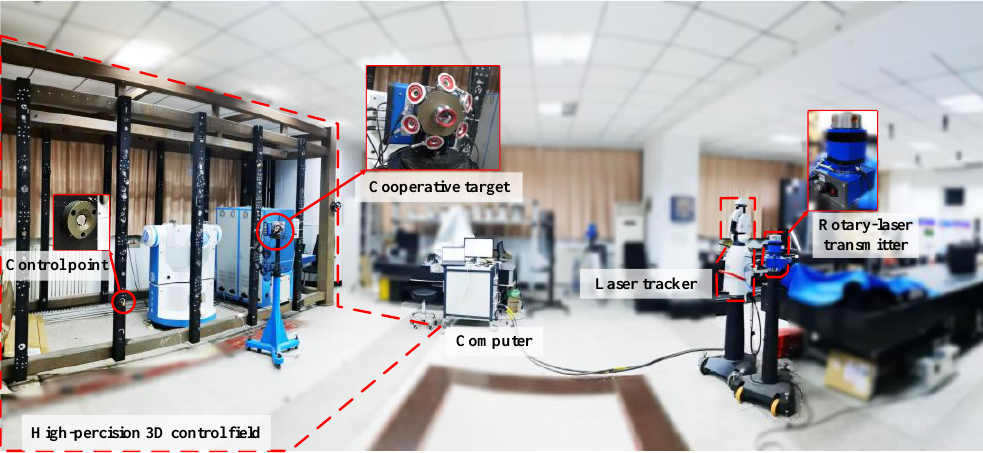
Figure 7. The layout of the devices, cooperative target, and the high-precision control field. Table 1. Coordinates of receivers and retroreflector in TCS.